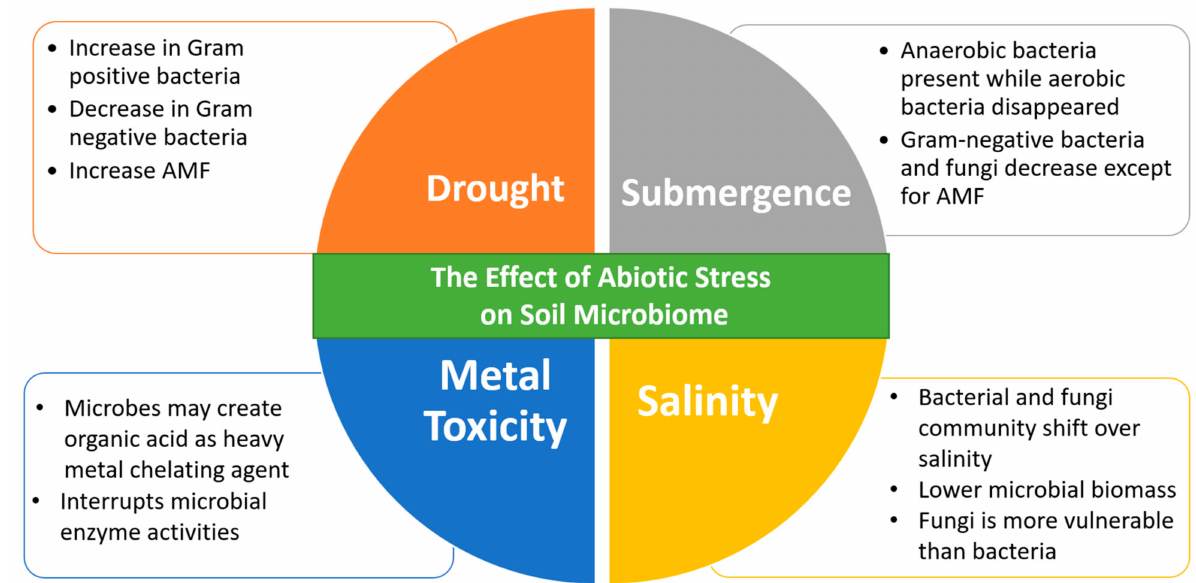
Figure 1. The above diagram shows the effect of changes in environmental factors on the soil microbial composition, health and